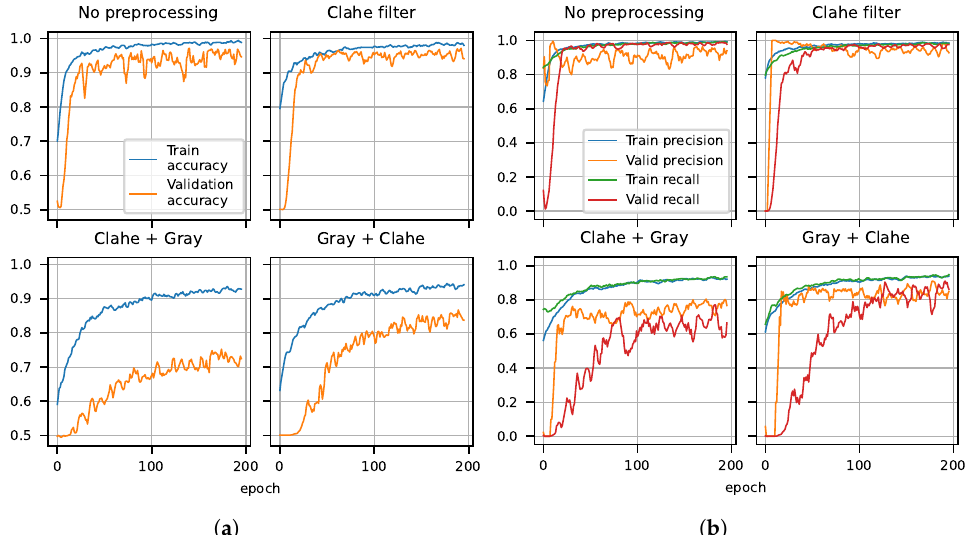
Figure 6. ( a ) Training and validation accuracy for OilNet40 trained on four different versions of the dataset. The model trained on the dataset preprocessed with CLAHE shows more stability and reaches the highest accuracy. ( b ) Precision and Recall for training and validation of OilNet40. The model performs best on color images. The model trained on the dataset filtered with CLAHE has the smallest number of false positive and